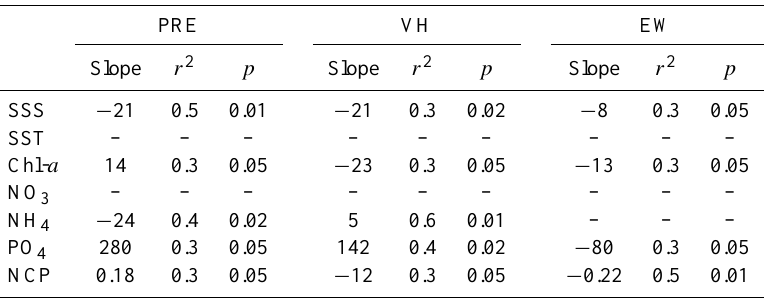
Table 2. Step-wise regression analysis performed for each region separately. p CO 2 is the dependent variable (y axis). Sea surface salinity (SSS), temperature (SST), Chl- a , NO 3 , NH 4 , PO 4 and net community production (NCP) is the independent variable, respectively. Slope is not presented when significant value p > 0 . 05. n = 14 to 25.